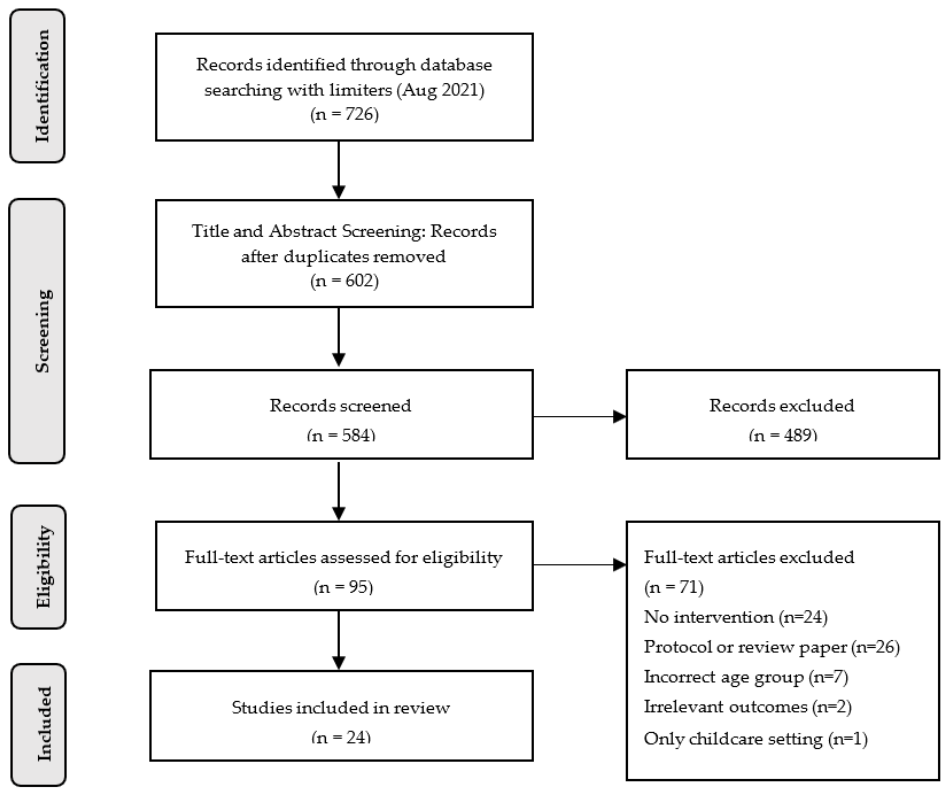
Figure 1. PRISMA Flow diagram of excluded articles throughout the review process.